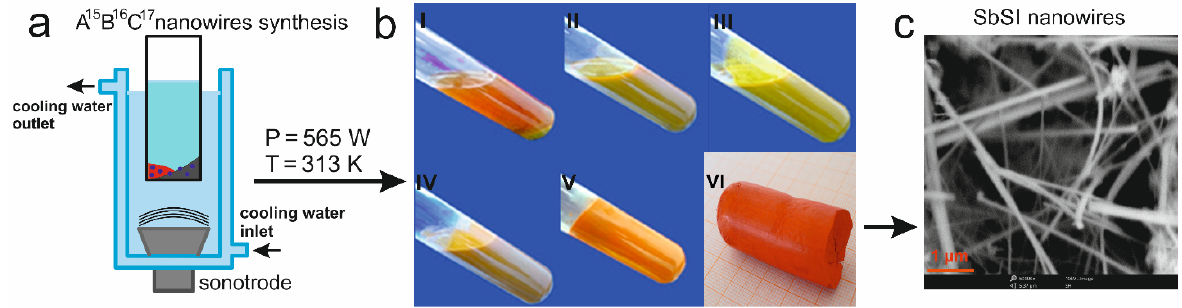
Figure 2. Schematic diagrams showing the synthesis technique for A 15 B 16 C 17 nanowires. ( a ) Elements from groups 15, 16, 17 are flooded with liquid and placed into a sonochemical reactor. ( b ) Changes in color and consistency are observed during an exemplary synthesis reaction of SbSI nanowires (over the time period: I—0 min, II—20 s, III—6 min, IV—26 min, V—120 min); image (VI) is a photograph of the obtained SbSI gel. ( c ) An SEM image of the SbSI nanowires.